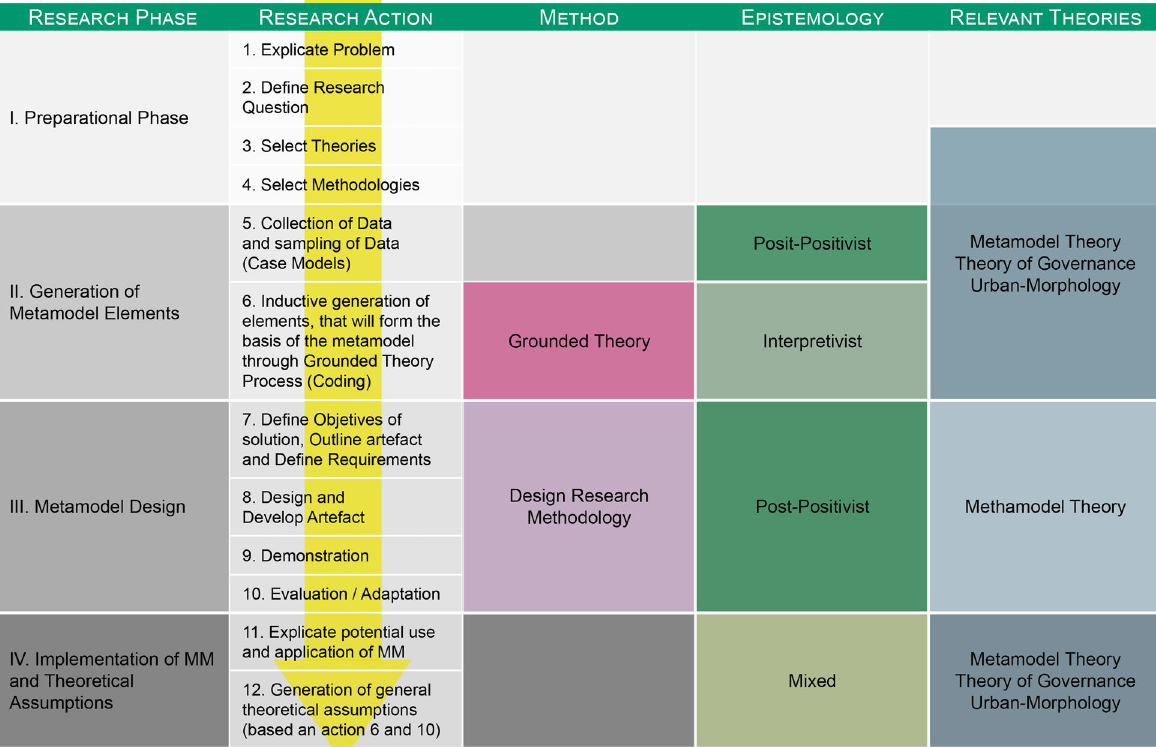
Fig. 2 Mixed-methods research design for the development of the metamodel (Source: Ripp